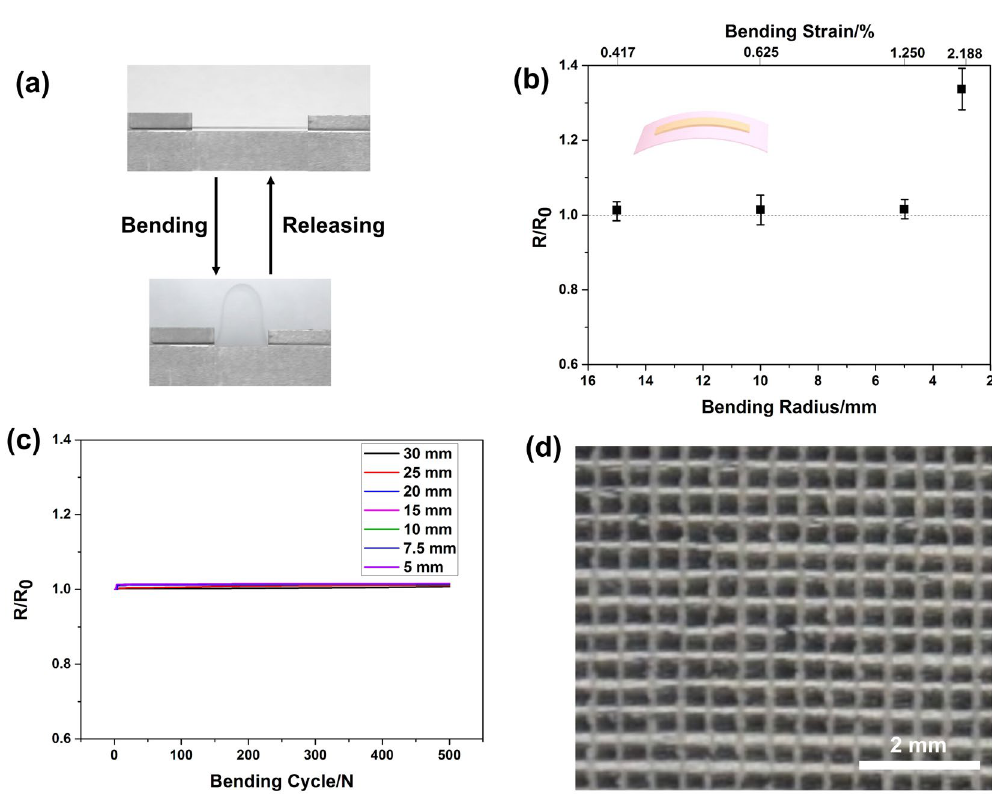
Figure 6. ( a ) Photograph of the bending test process. ( b ) Resistance changes of AgNW line as a function of tensile bending radius and bending strain. ( c ) Dynamic bending fatigue tests of AgNW line at the bending radii of 30, 25, 20, 15, 10, 7.5 and 5 mm, respectively. ( d ) Optical image of the printed 150 µ m-width AgNW grid with line spacing of 500 µ